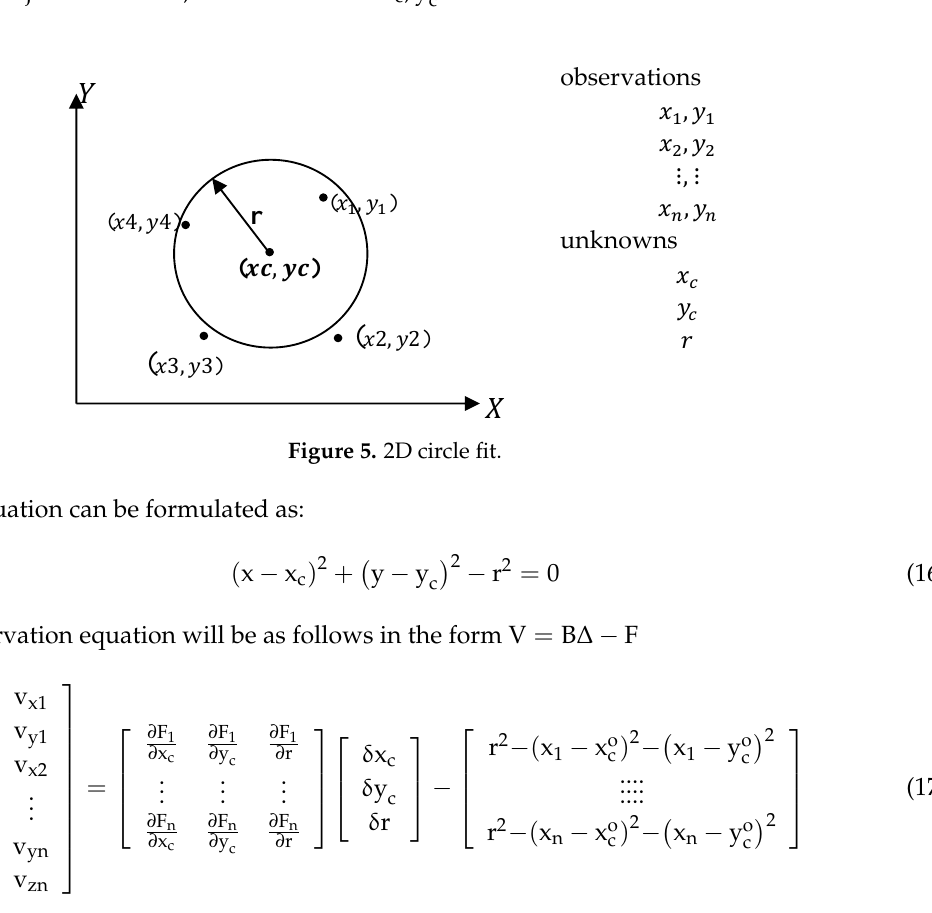
Figure.6. Rotating from normal vector 𝑛1 to normal 𝑛2 . 207